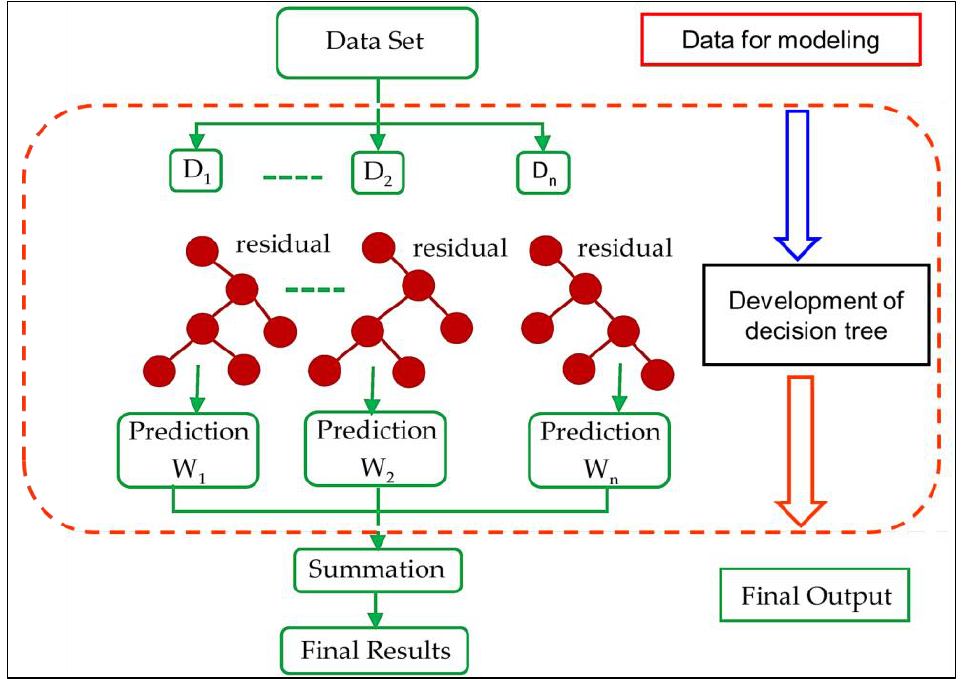
Figure 3. Schematics of XGBoost [72].